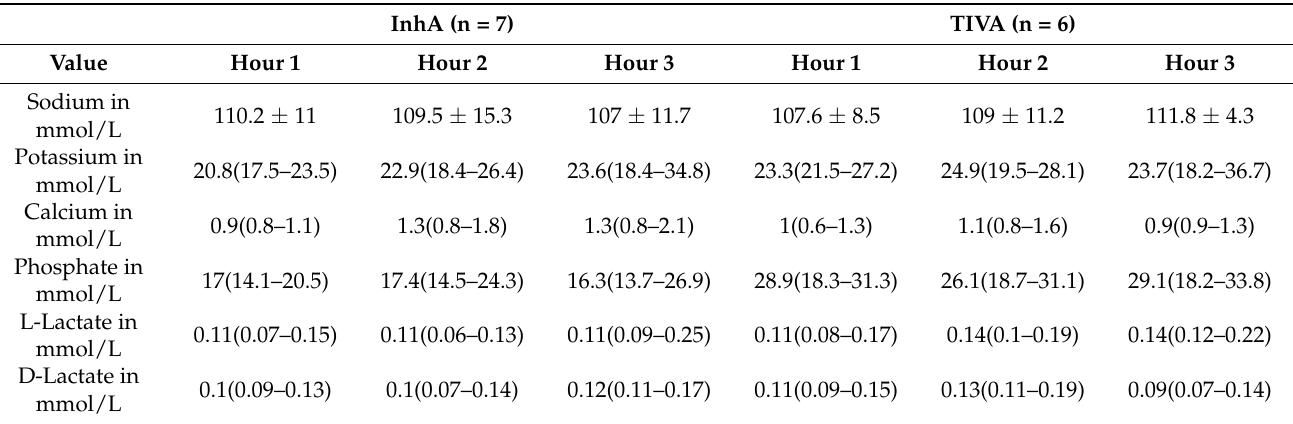
Table 3. Parameters in ruminal fluid of 13 sheep during laparotomy under two different anaesthe- sia